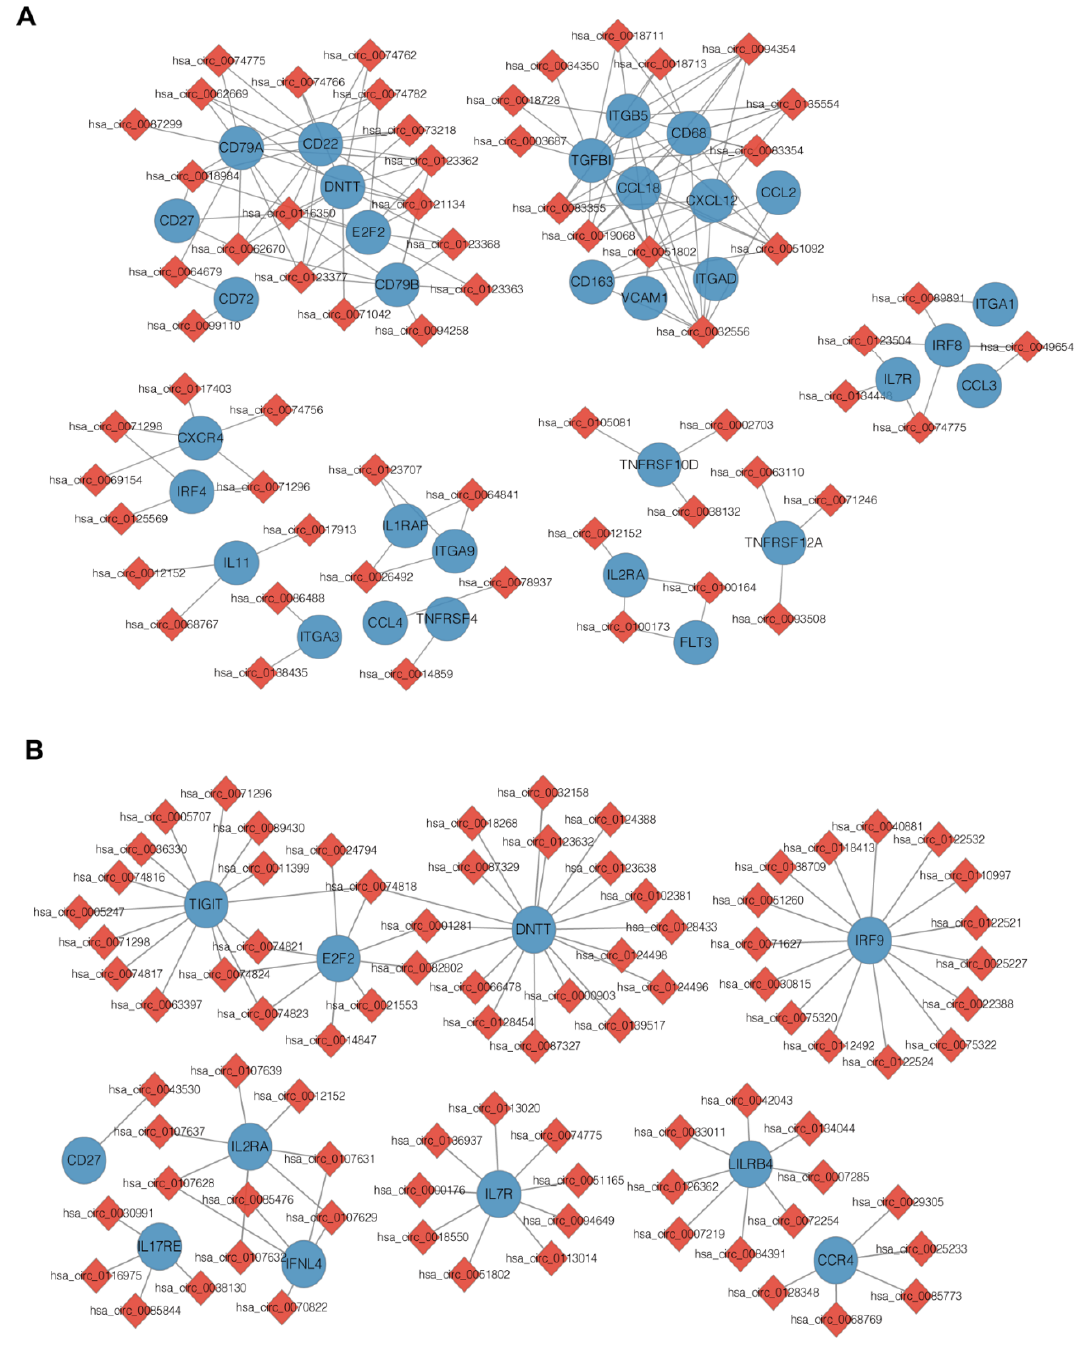
Figure 4. DE circRNAs and mRNAs co-expression networks in the immune-related pathways. ( A ) Co-expression network of the DE circRNAs and DE mRNAs present in the CD34 + cells from patients with AML relapse versus remission. ( B ) Co-expression network of the DE circRNAs and DE mRNAs present in the CD34 + cells from patients with AML relapse versus healthy controls.